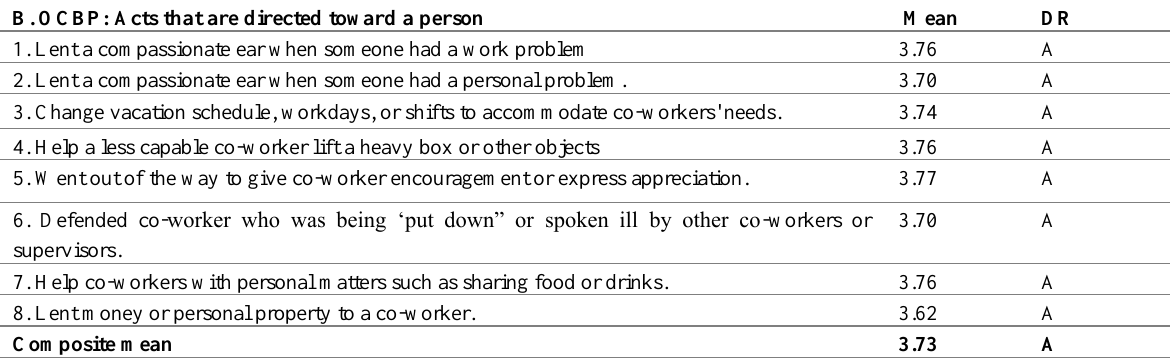
Table 2: The Organizational Citizenship Behavior of Employees as to OCBP